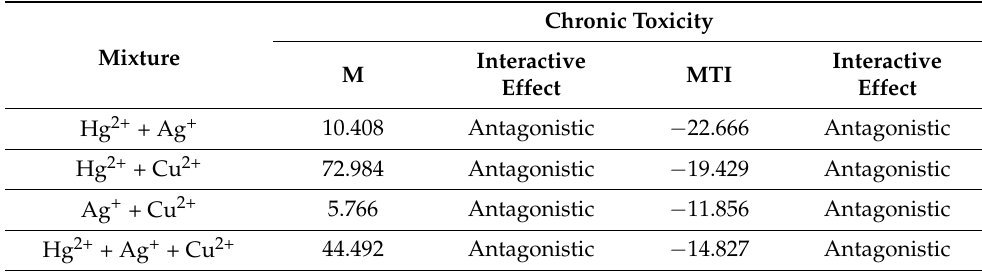
Table 7. TU and MTI approaches to determine the interaction of two and three combined